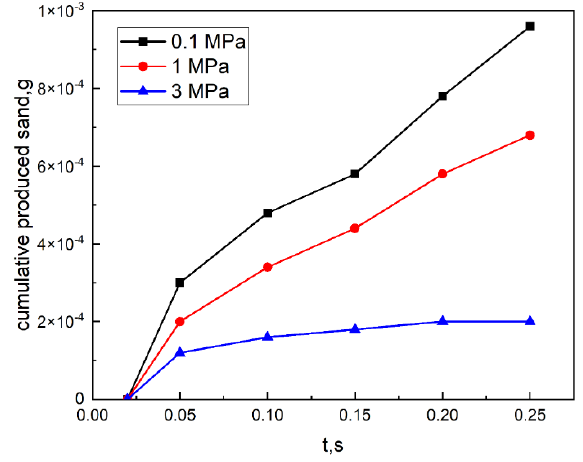
Figure 13. Cumulative weight of produced sand at different confining pressure.